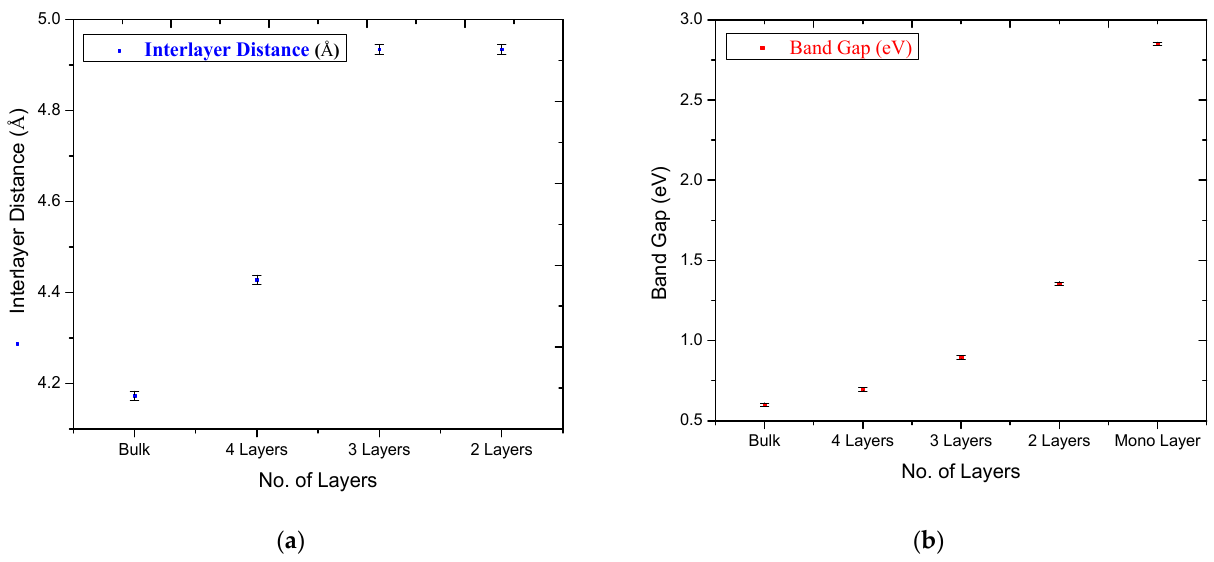
Figure 5. ( a ) Inter layer distance ( b ) Band gap, as a function of the number of layers of SnO. A decrease in the number of layers will reduce these forces and, eventually, an increase in the band gap can be observed clearly in Figure 5. The comparison of calculated TDOS and PDOS calculated for 4 layers, 3 layers and 2 layers of SnO is given in Figure 6. It shows the gradually decreasing orbital contribution of Sn:5s from 4 layers to 2 layers of SnO in the formation of VBM. It happened due to the drop in Sn–Sn interlayer interactions which gradually decrease from bulk to monolayer SnO. There is a gap of 0.697 eV, 0.89 eV and 1.35 eV between CBM and VBM for 4 layers, 3 layers and 2 layers, respectively. As the number of layers is diminishing, the band gap starts increasing in the same way and gets its maximum value for the monolayer where we have just one layer of SnO. This band gap engineering tool is incredibly effective to control the structural, electronic and optical properties of future smart materials. The free surface present with lone pair states becomes the reason for band gap opening in monolayer SnO. Due to its optical transparency, 2D SnO is favorable for future optoelectronics devices. Being one of the semiconductor oxides which have optical transparency, high carrier mobility and ambipolar conductivity, 2D SnO is considered the most suitable material for future thin film transistors.